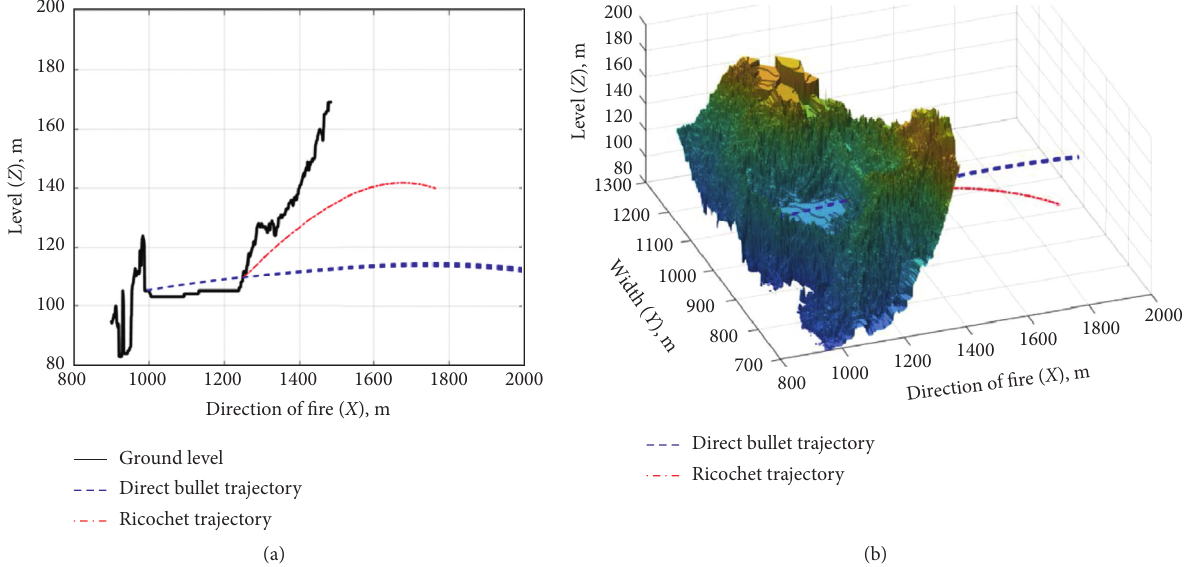
Figure 9: Bullet trajectory curves with topographic data (1000 fires of K2 rifle and K100 bullet with 4.9MOA). (a) 2D section and (b) 3D topology.